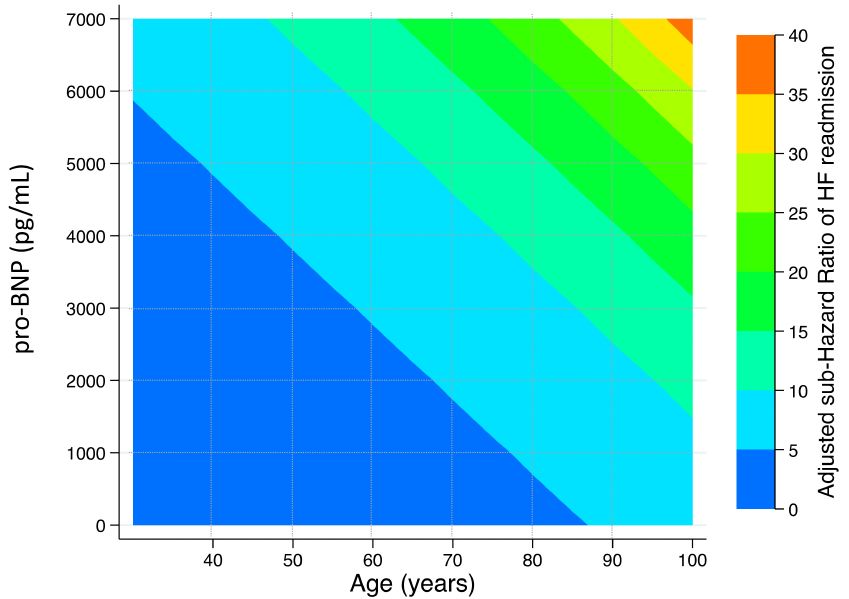
Figure 3. Relative sub-hazard risk of readmission for heart failure according to age and pro-BNP